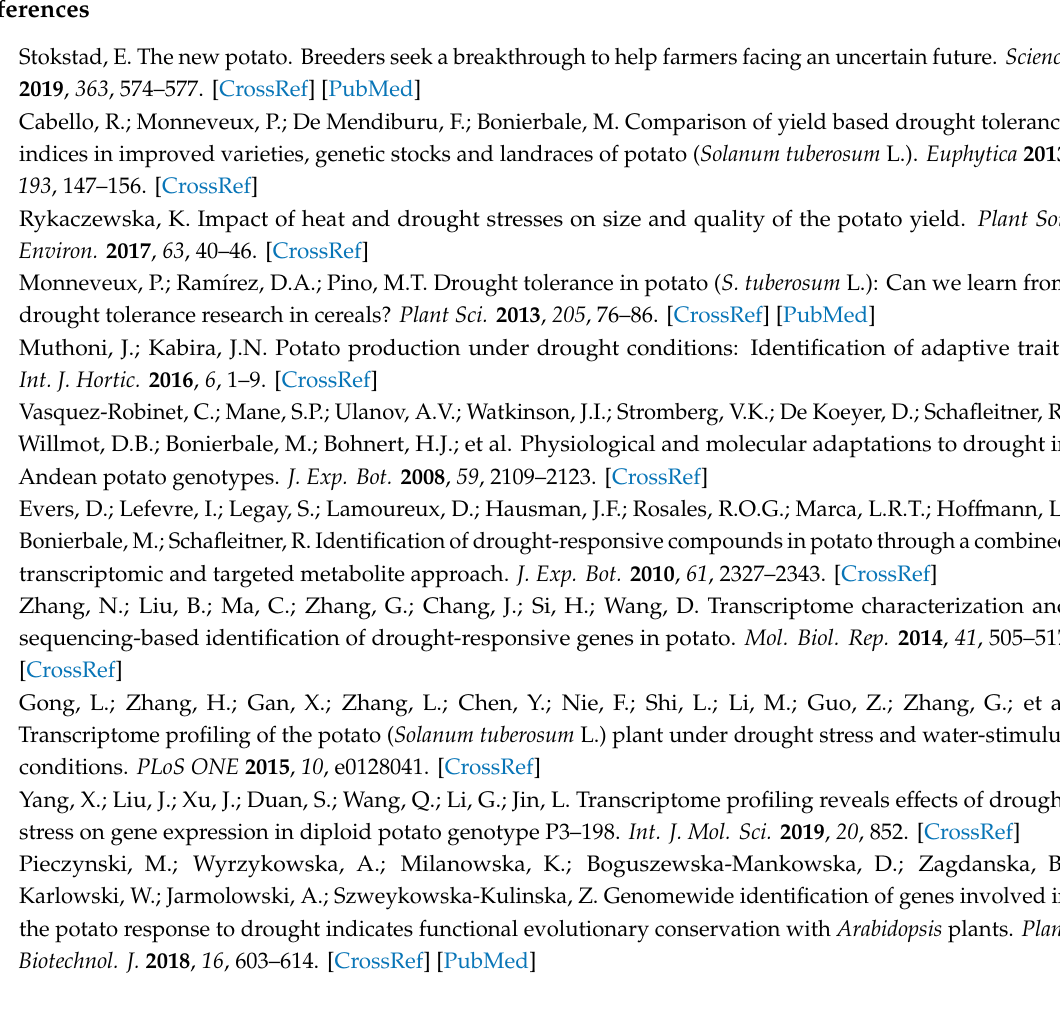
Table S1. The overview of transcriptome sequencing results. Table S2. Drought responsive gene in potato (C0 vs. D1). Table S3. DEGs after rehydration. Table S4. Drought hardened DEGs. Table S5. Primers for qRT-PCR